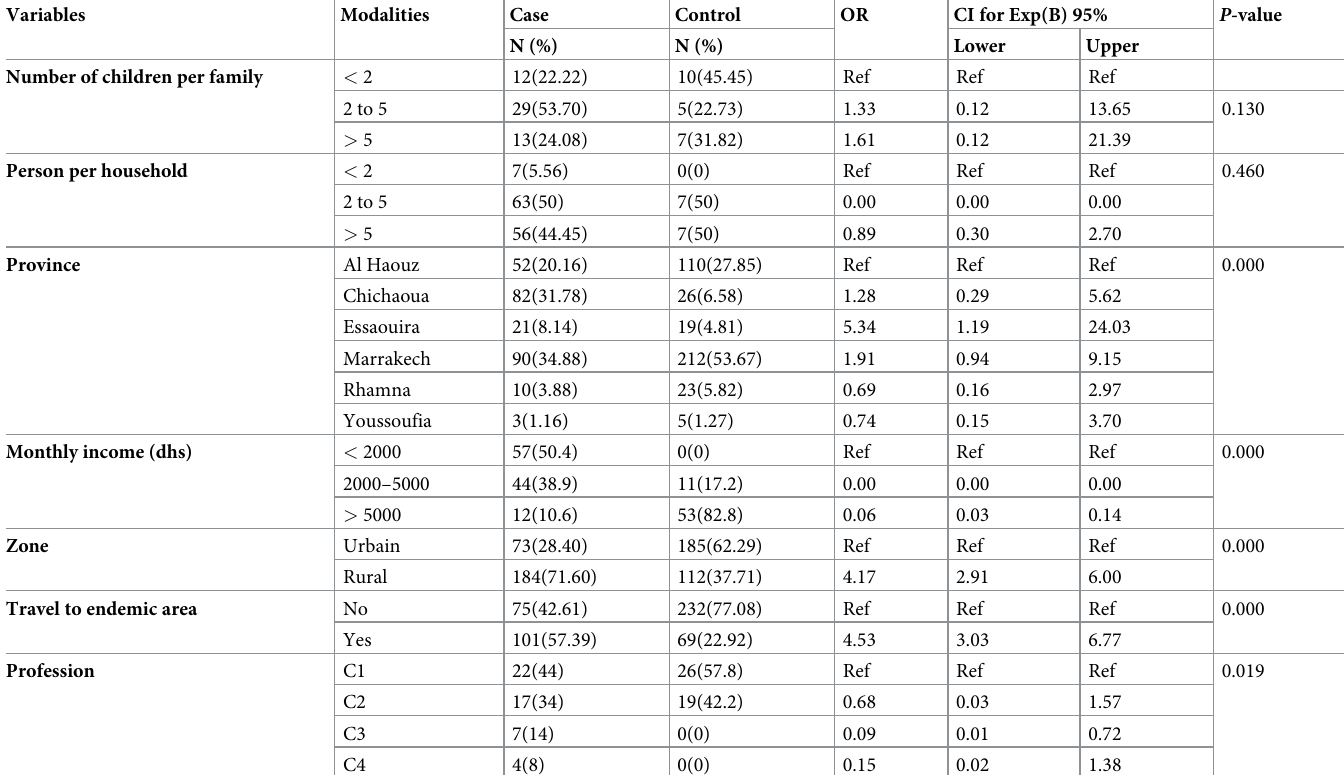
Table 2. Socio-economic determinants associated with ACL, in the Marrakech-Safi region, Morocco between 2018 and 2020. Variables